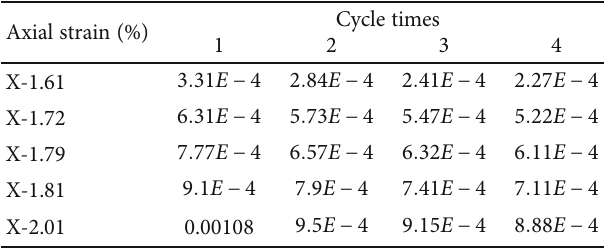
Table 5: The relative residual strain of ε axial strains.